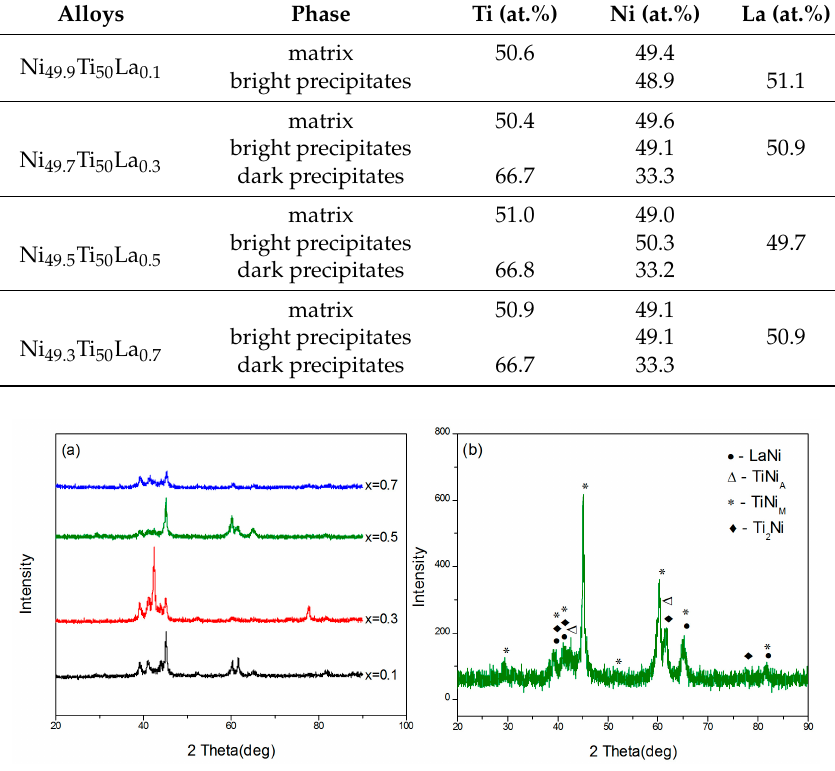
Figure 4. XRD patterns of Ni 50 − x Ti 50 La x alloys: ( a ) All alloys; ( b ) phases corresponding to diffraction peaks of Ni 49.5 Ti 50 La 0.5 .